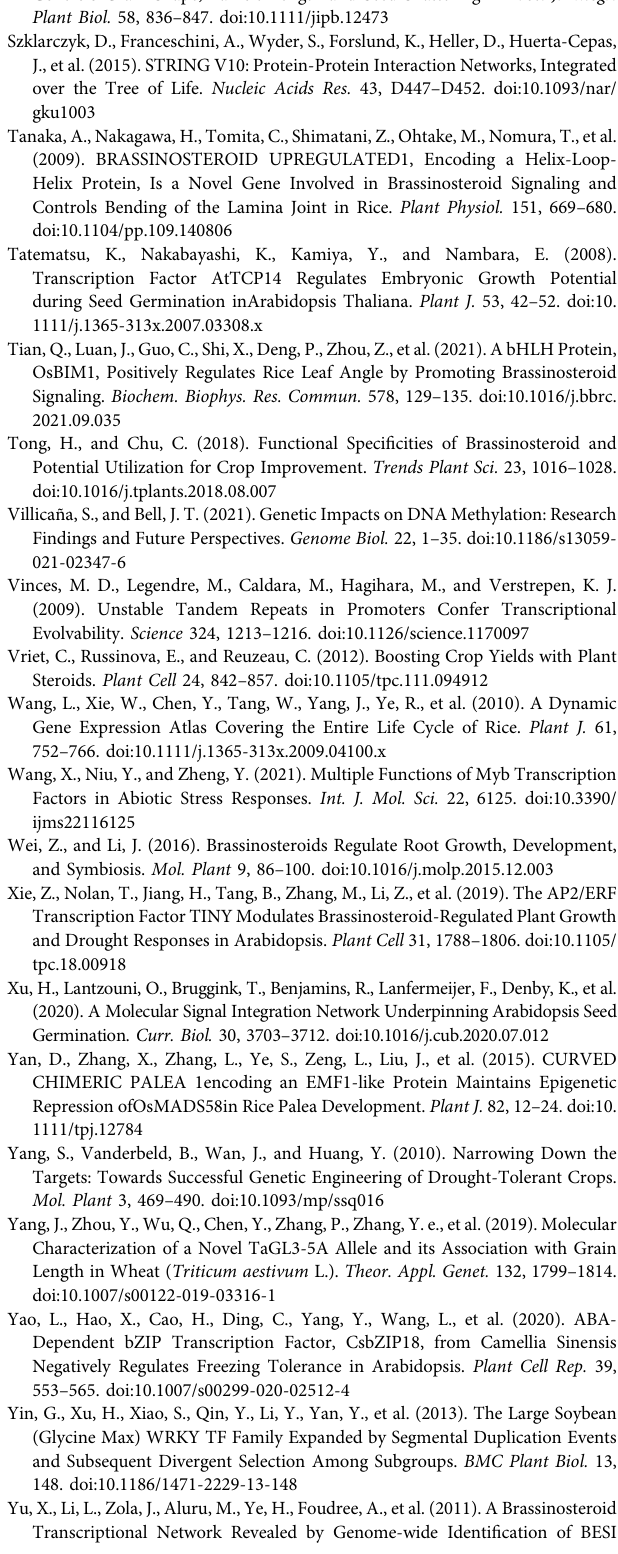
148. doi:10.1186/1471-2229-13-148 Yu,X., Li, L., Zola, J.,Aluru,M.,Ye, H.,Foudree, A., etal. (2011).ABrassinosteroid Transcriptional Network Revealed by Genome-wide Identi fi cation of BESI